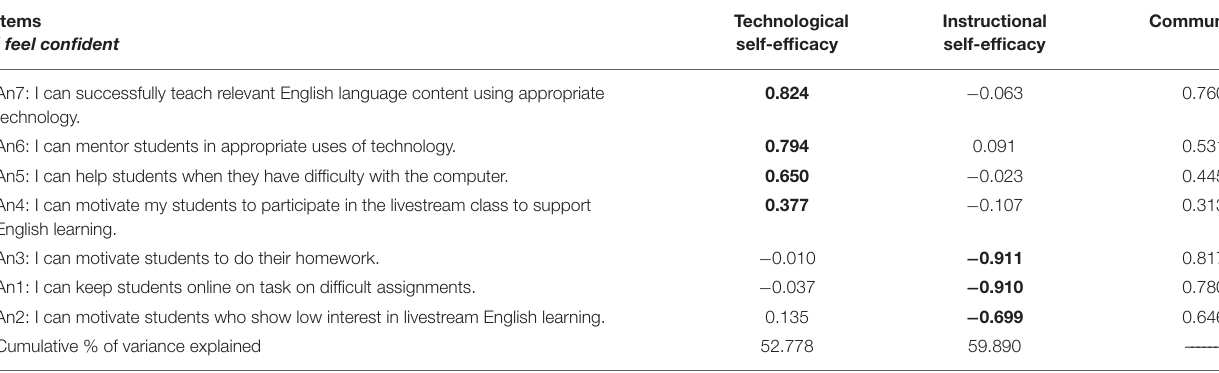
TABLE 4 | Pattern matrix of the T-SE Q. Items I feel confident